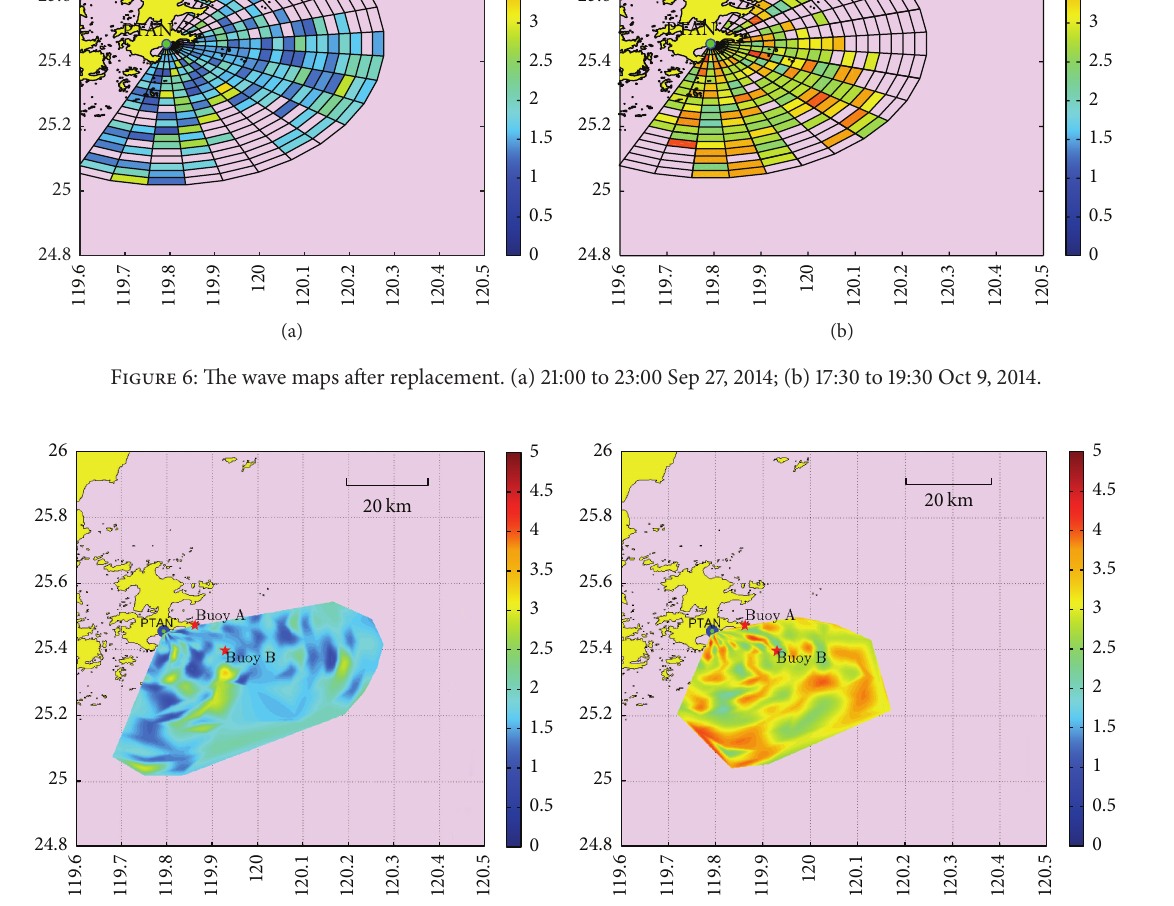
different in the further sea areas, which may be due to higher propagation losses in rough